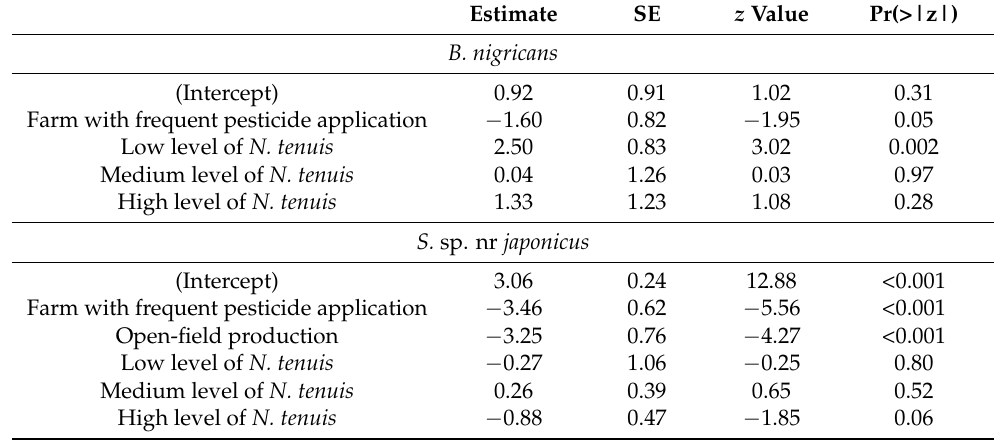
Table 2. Statistical estimates for the effect of agroecological parameters on the parasitoid’s abundance.